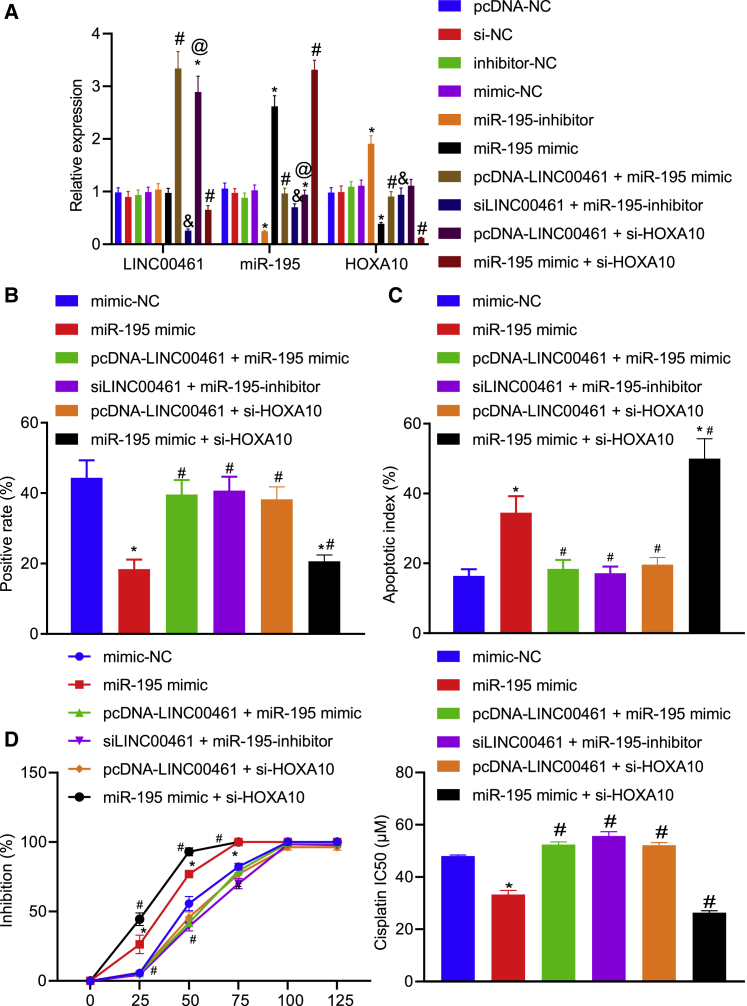
The LINC00461/miR-195/HOXA10 axis mediates chemoresistance of HNSCC cells(A) The expression of LINC00461, miR-195, and HOXA10 in the FADU cells detected by qRT-PCR. (B) The proliferative capacity of FADU/DDP cells. Red fluorescence represents proliferated cells and blue fluorescence represents nuclei. (C) The apoptosis rate of FADU/DDP cells. (D) Dose detection and data statistics of cisplatin IC50 following varied treatments. All of the data were measurement data expressed as means ± standard deviations. The data among multiple groups were compared using 1-way ANOVA. The experiment was conducted 3 times independently. ∗p < 0.05 versus the mimic-NC group. #p < 0.05 versus the miR-195 mimic group. &p < 0.05 versus the miR-195-inhibitor group. @p < 0.05 versus the pcDNA-LINC00461 + miR-195 mimic group.